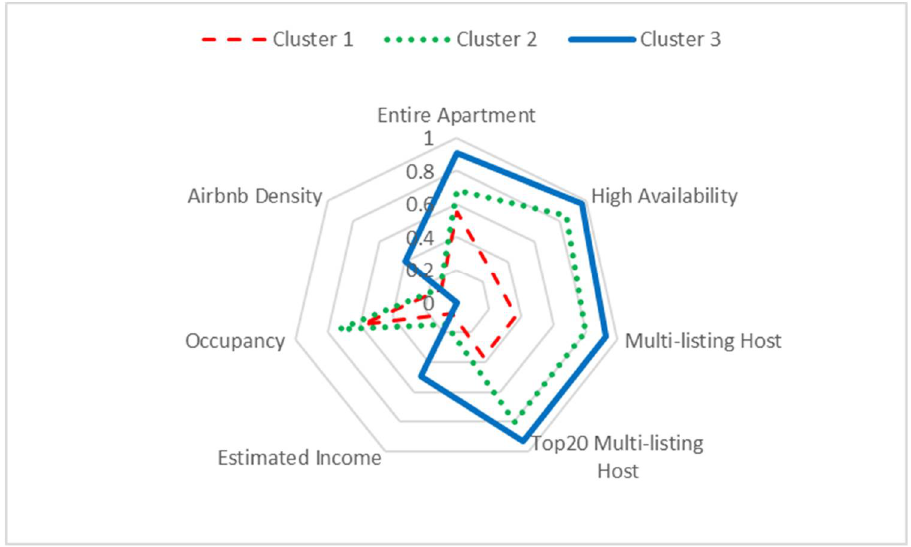
Figure 5. Profiles of the three clusters. Source: author’s own elaboration.